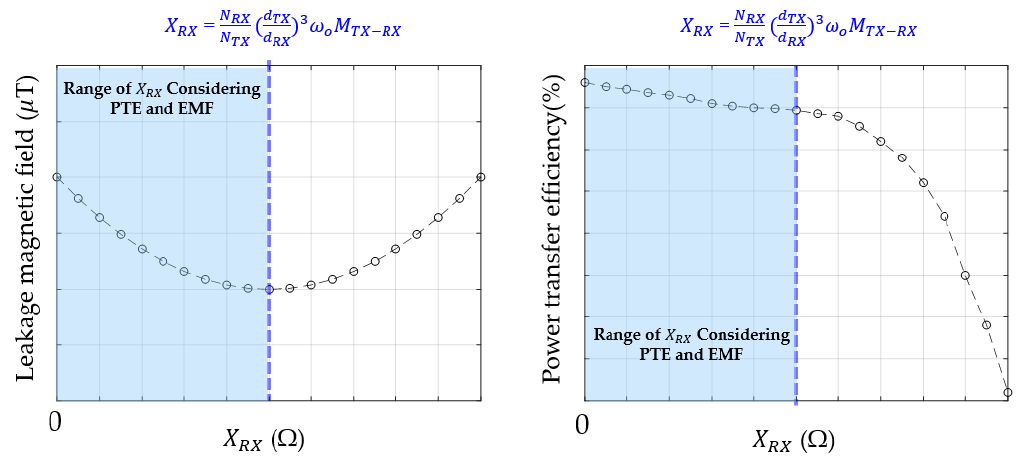
Figure 8. The leakage magnetic field and PTE of the WPT system with changes in 𝑋 𝑅𝑋 .